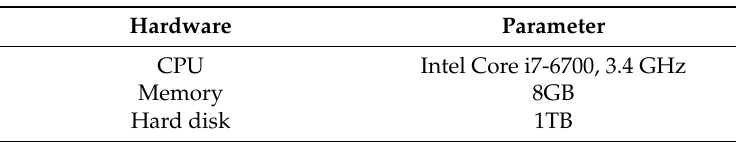
Table 3. Hardware